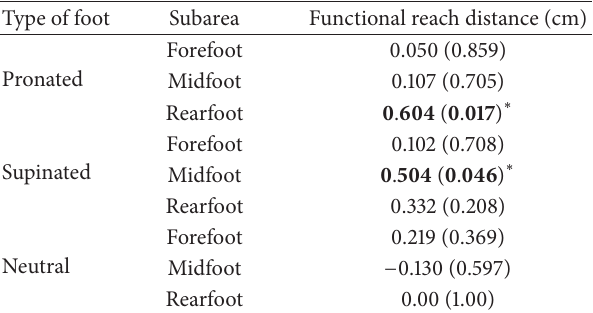
Table 3: Spearman Rank Correlation for max 𝑃 and anthropomet- rics and physiological factors in pronated, supinated, and neutral foot ( 𝑟 𝑠 ( 𝑝